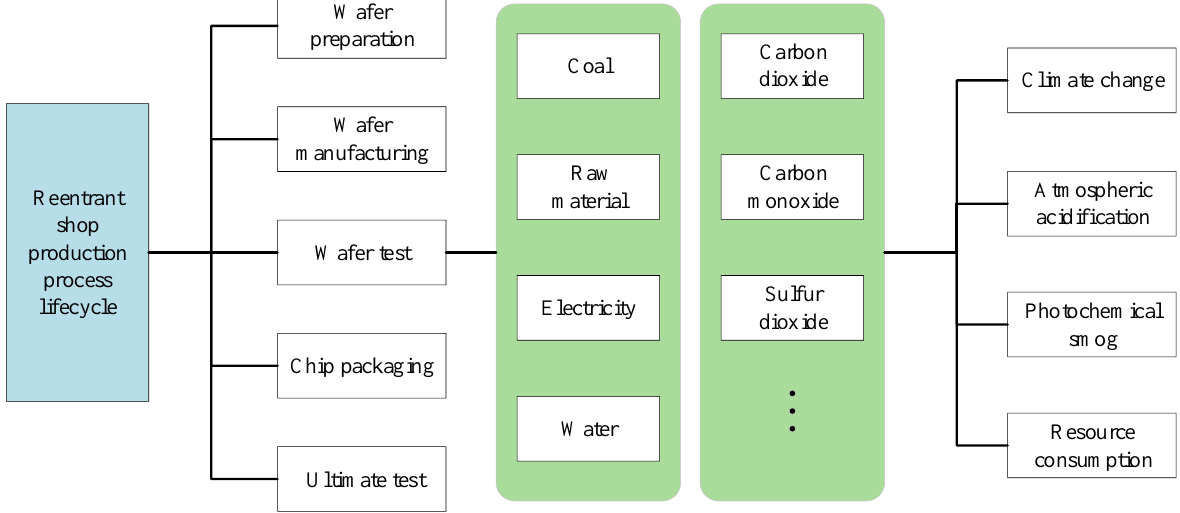
Figure 2. Environmental impact assessment model.